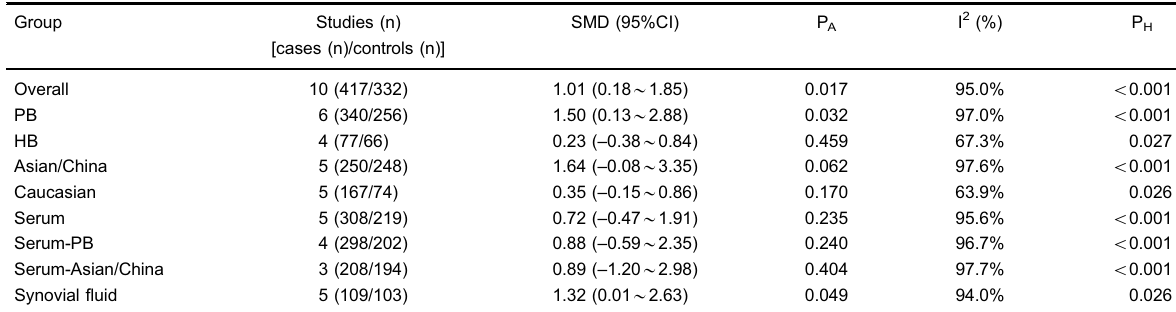
Table 1. Pooling analysis of matrix metalloproteinase-1 level and rheumatoid arthritis risk.